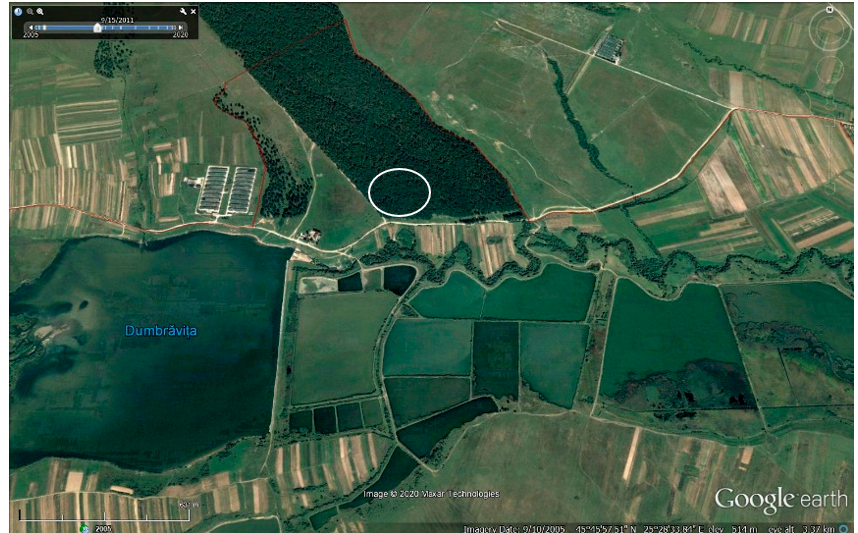
Figure 7. Colony location on fishponds from Dumbr ă vi ț a, 2010–2020 (white oval, A. cinerea ; black oval, A. purpurea ).